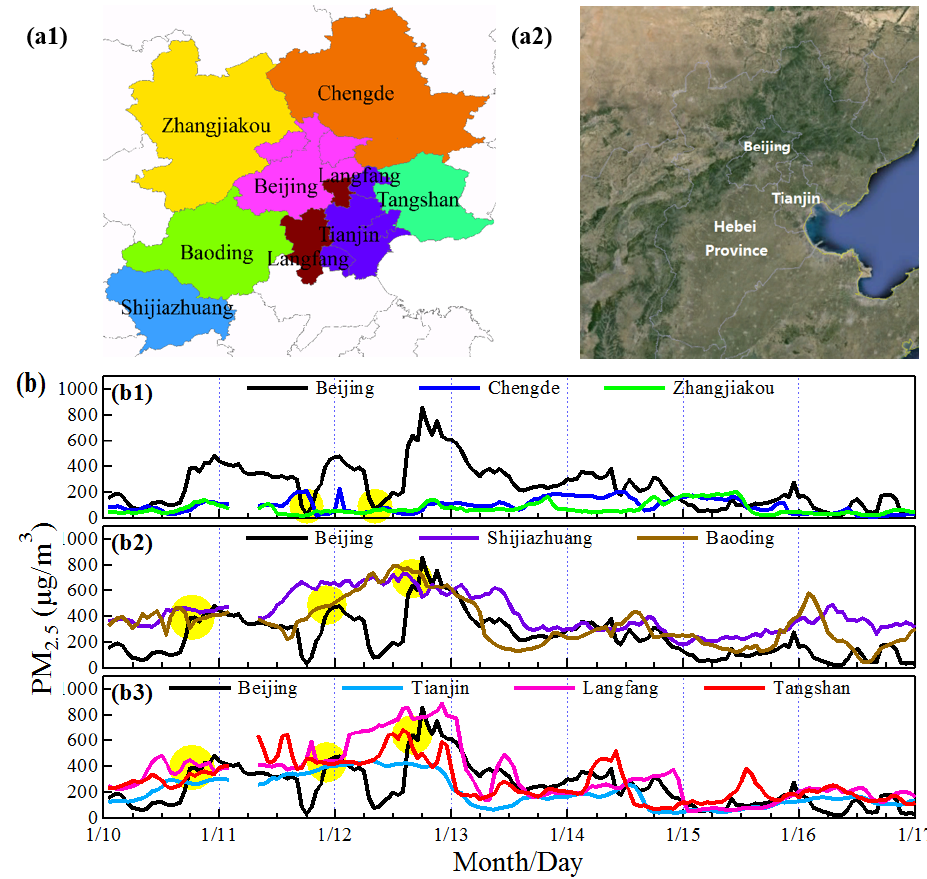
Figure 6. (a1) The location of all cities shown below, and (a2) topographic map around Beijing. (b) PM 2 . 5 concentrations of Beijing and its (b1) northern cities, (b2) southwest cities, and (b3) southeast cities for the period 10–17 January 2013. Yellow solid circles indicated the time periods when the sharp drops (b1) and sharp increases ( b2 and b3 ) of PM 2 . 5 concentration